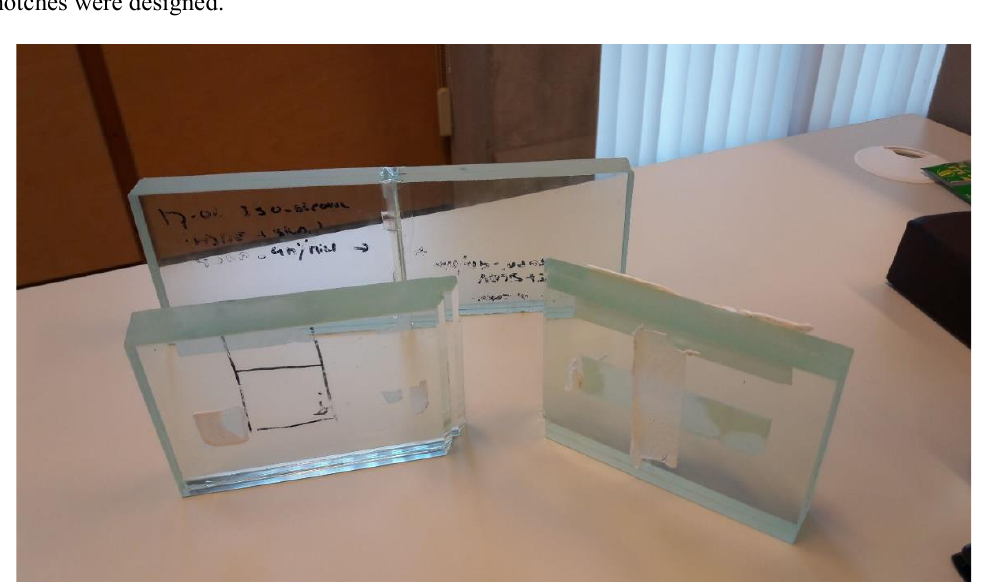
Fig. 7 test pieces of Araldite